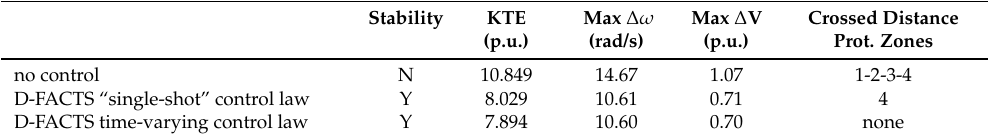
Table 1. Indicators of system dynamic performance.